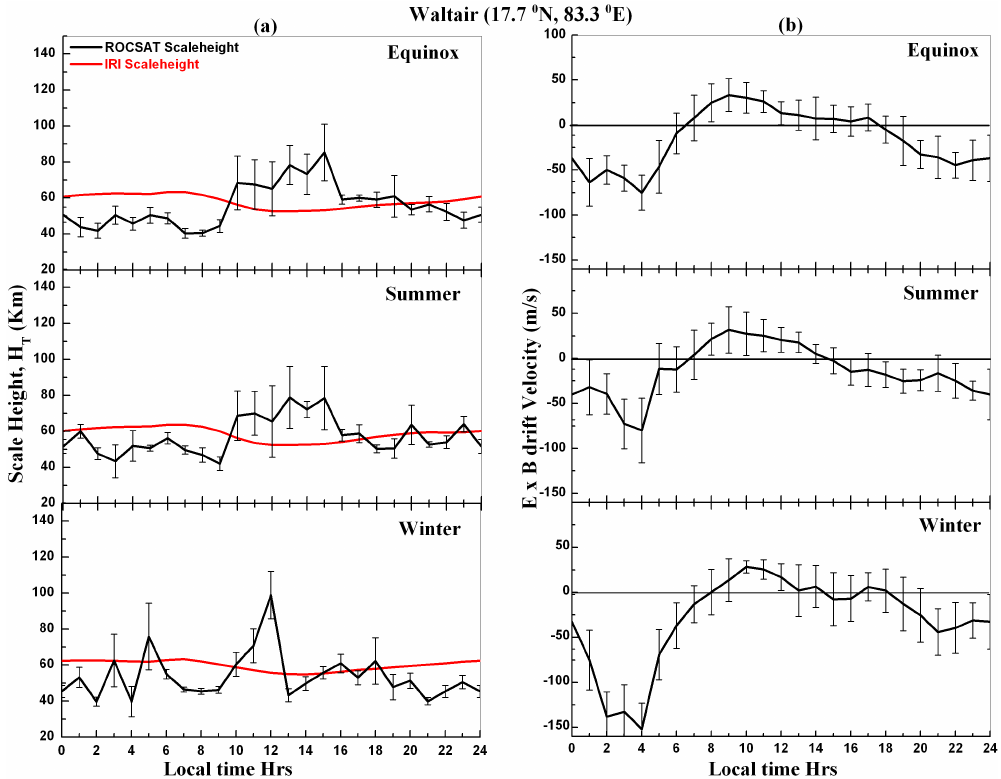
Fig. 9. The mean diurnal variations of effective scale height ( H T ) and E × B drift velocities (measured by ROCSAT-1 satellite and IRI model (red line)) over Waltair during three different